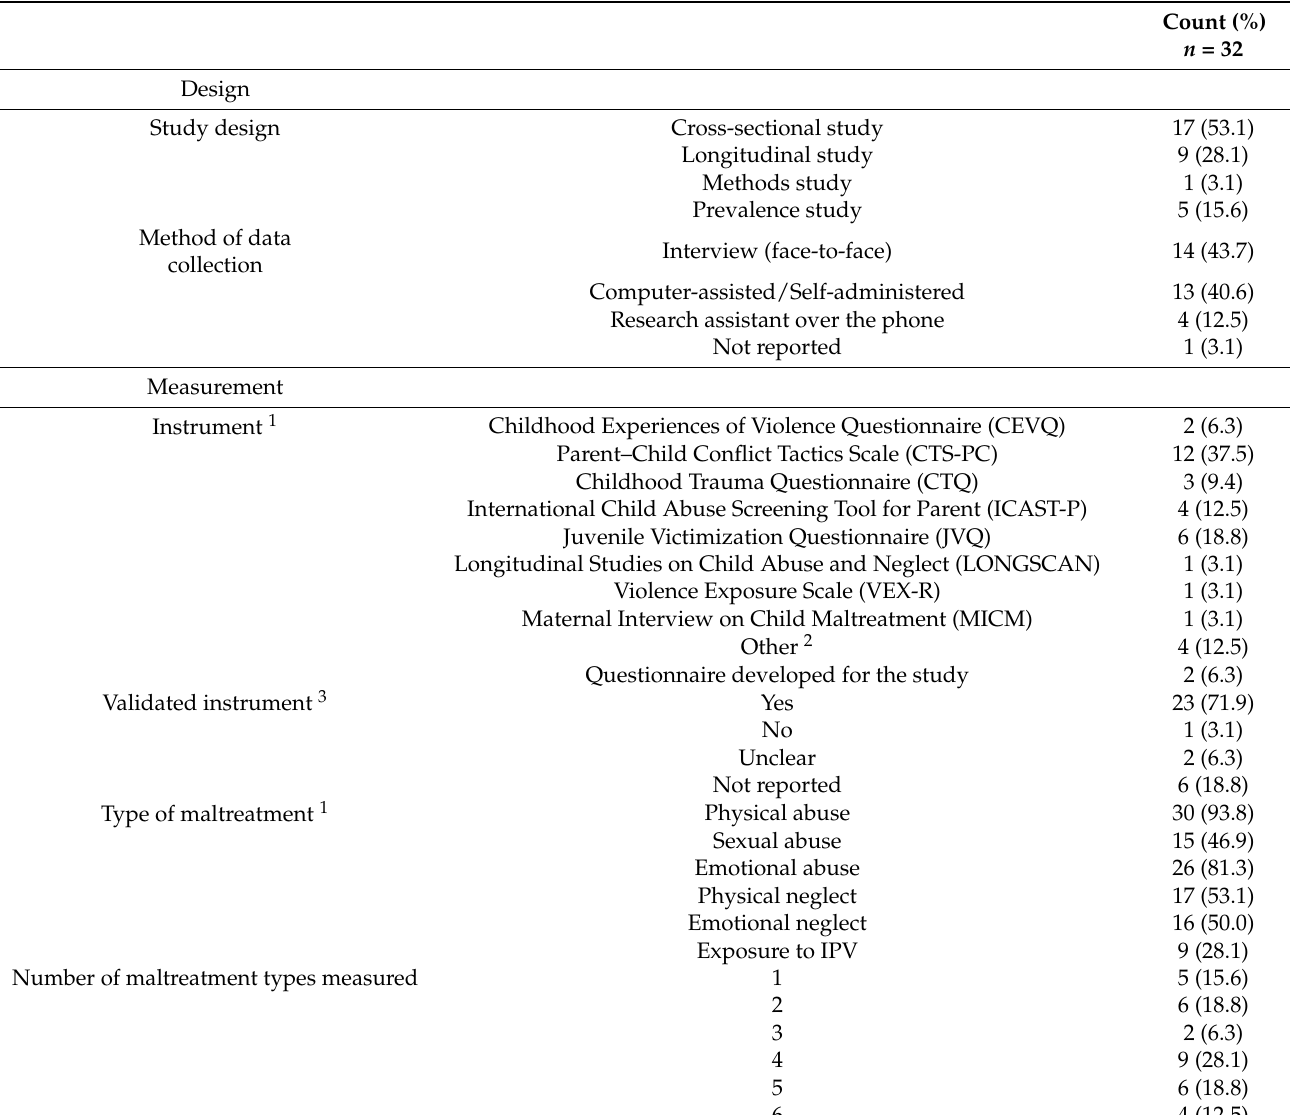
Table 4. Study design, methods, and measures to document experiences of child